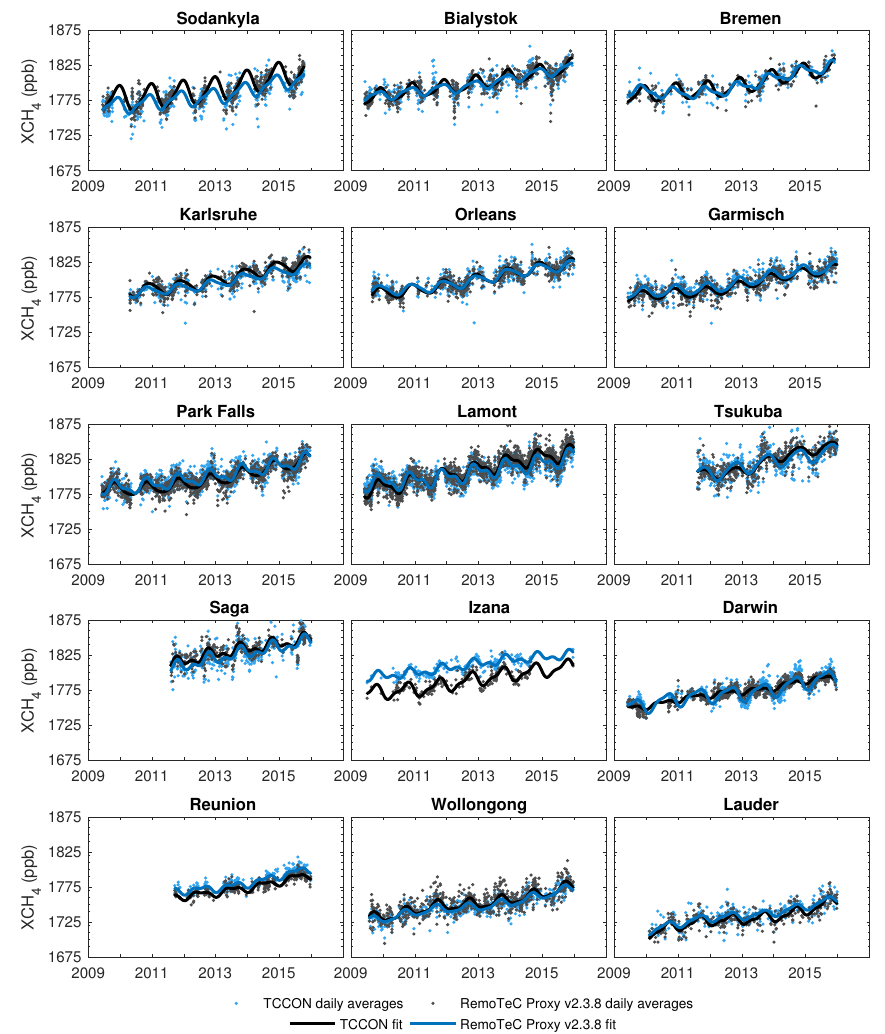
Figure 4. Daily averages and DLM fits of XCH 4 for RemoTeC Proxy retrievals at the 15 TCCON sites. The sites are arranged by their latitude from the northernmost (Sodankylä, 67.37 ◦ N) to the southernmost (Lauder 45.04 ◦